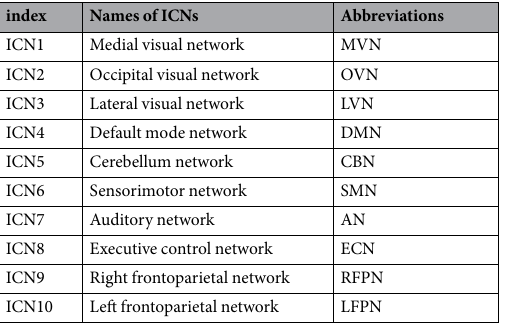
Table 8. Names of template